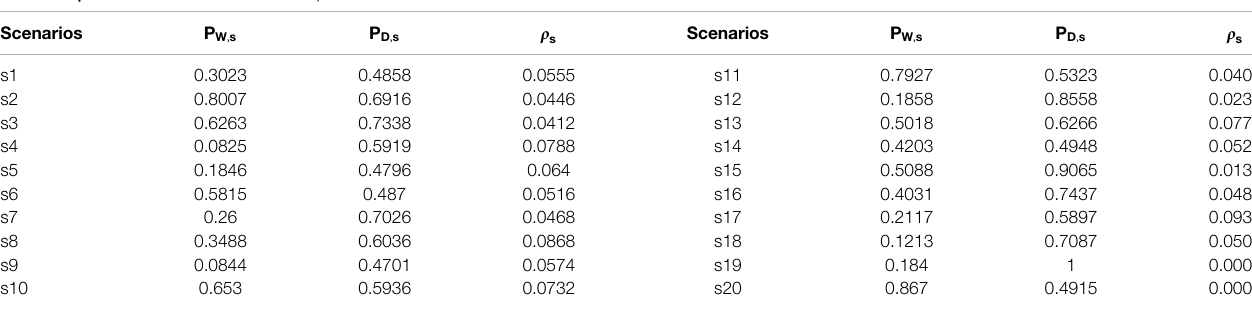
TABLE 1 | Load and wind scenarios and probabilities.